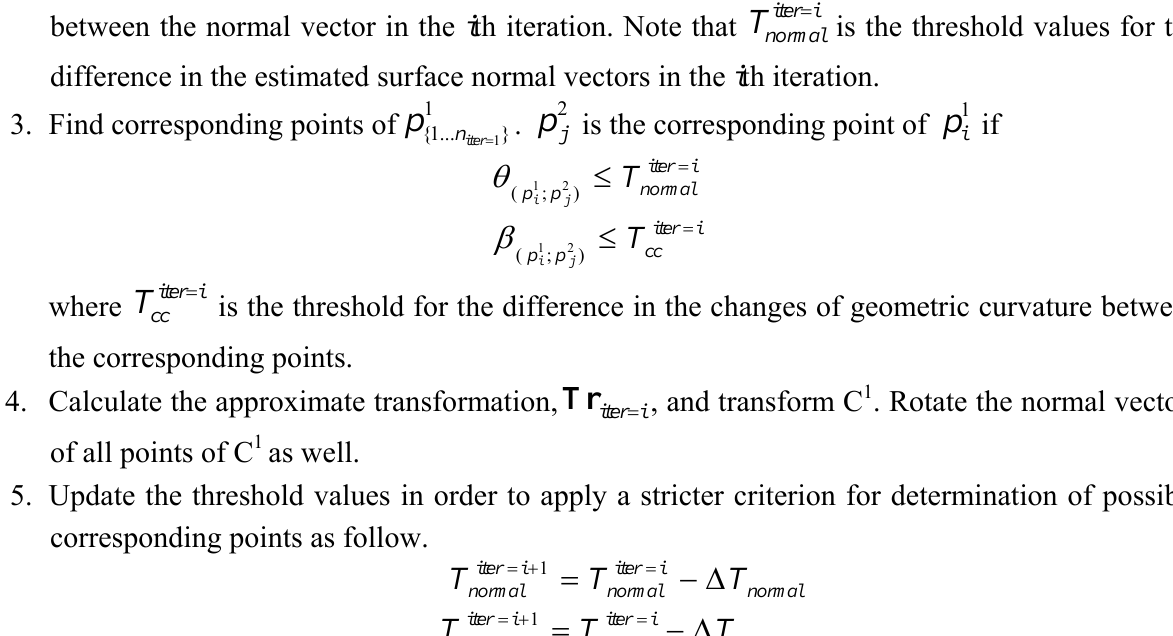
sampleiiter sampleiiter